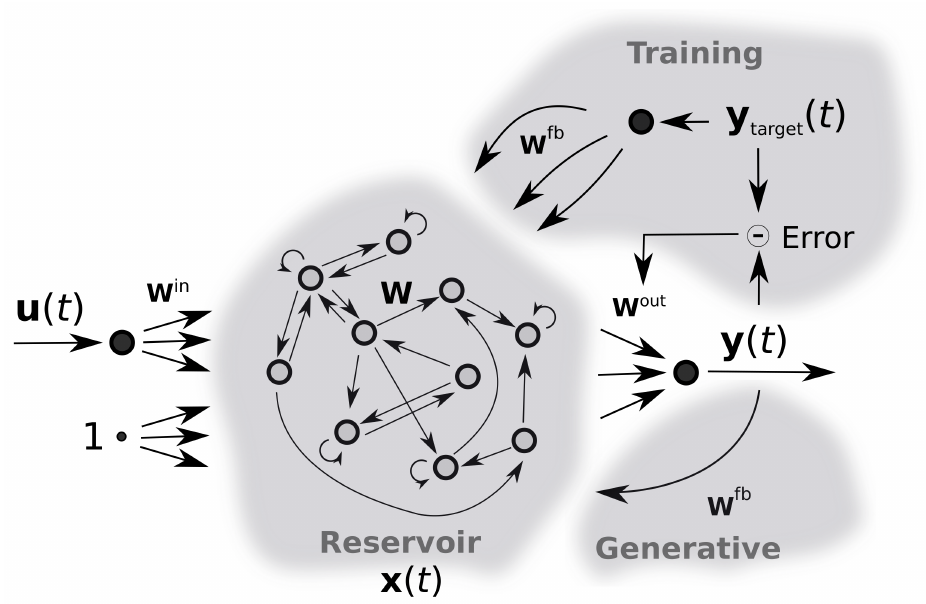
Figure A1. The basic echo state network